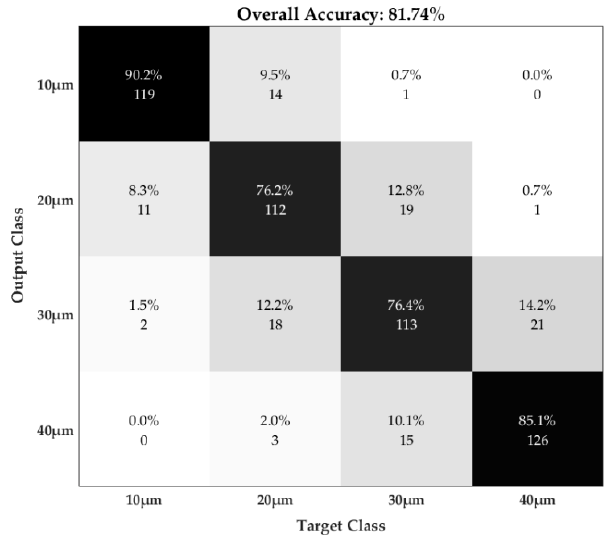
Figure 6. Confusion matrix of small scale crack detection using MSE-Faster R-CNN.